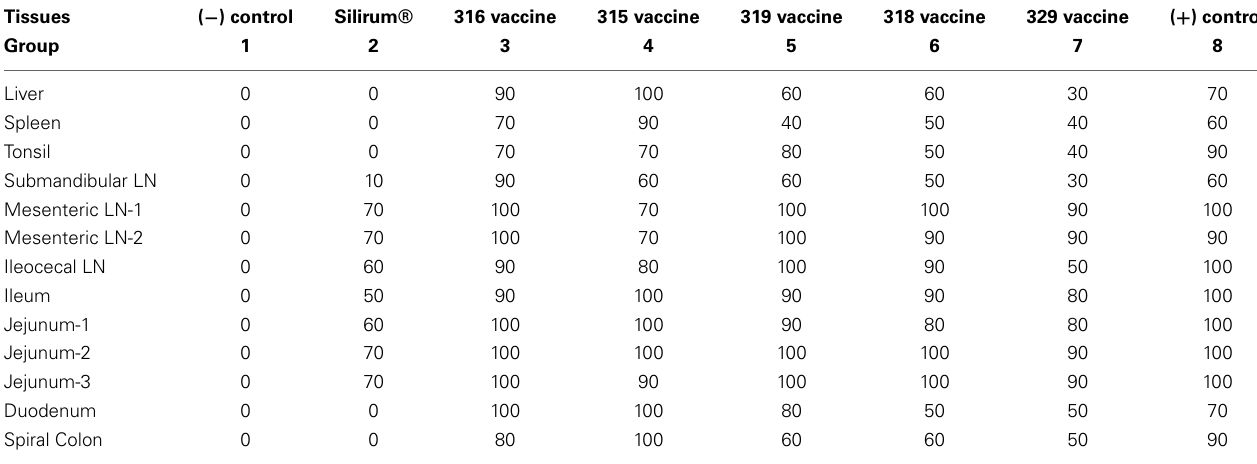
Table 5 | Tissue AgPath-ID MAP PCR percent